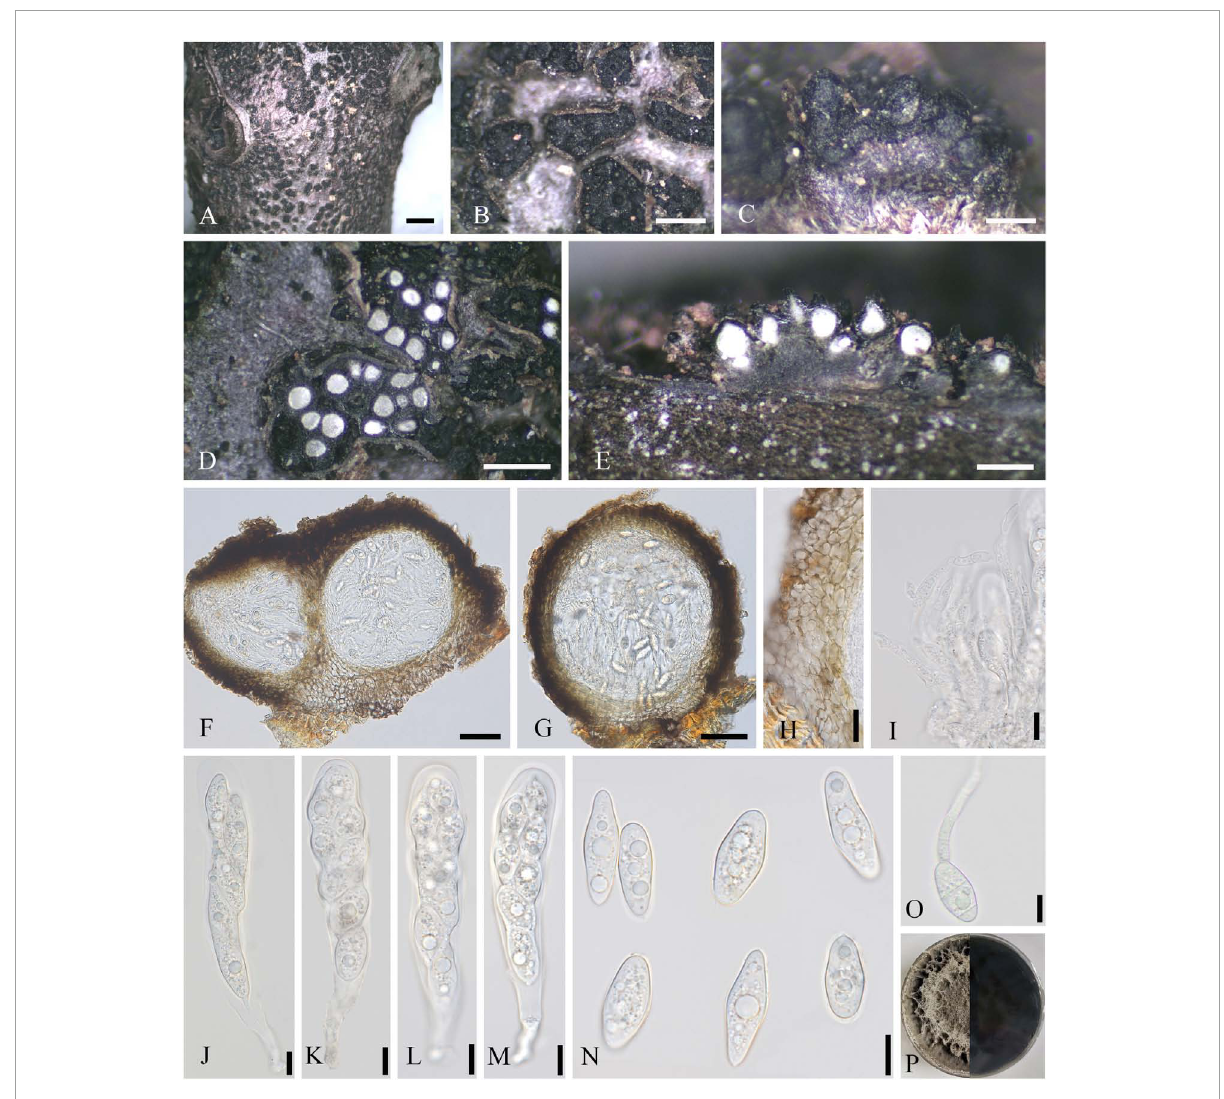
FIGURE6 Neofusicoccum sichuanense (SICAU 22-0098, holotype). (A–C) Stromata erumpent through twig surface. (D,E) Vertical and transverse sections through stromata. (F,G) Sections through locules. (H) Peridium. (I) Pseudoparaphyses. (J–M) Asci. (N) Ascospores. (O) Germinating ascospore. (P) Culture on PDA for 15 days. Scale bars: (A) 2 mm, (B,D) 500 µ m, (C,E) 200 µ m, (F,G) 50 µ m, (H) 20 µ m, and (I–O) 10 µ